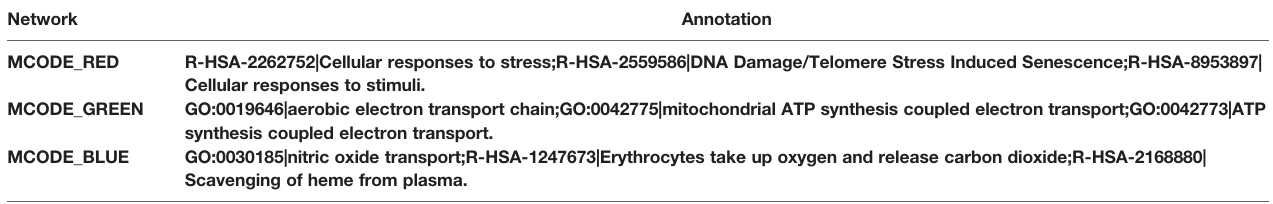
TABLE 1 | Functional enrichment of the core regulatory module of the protein-protein interaction network. Network